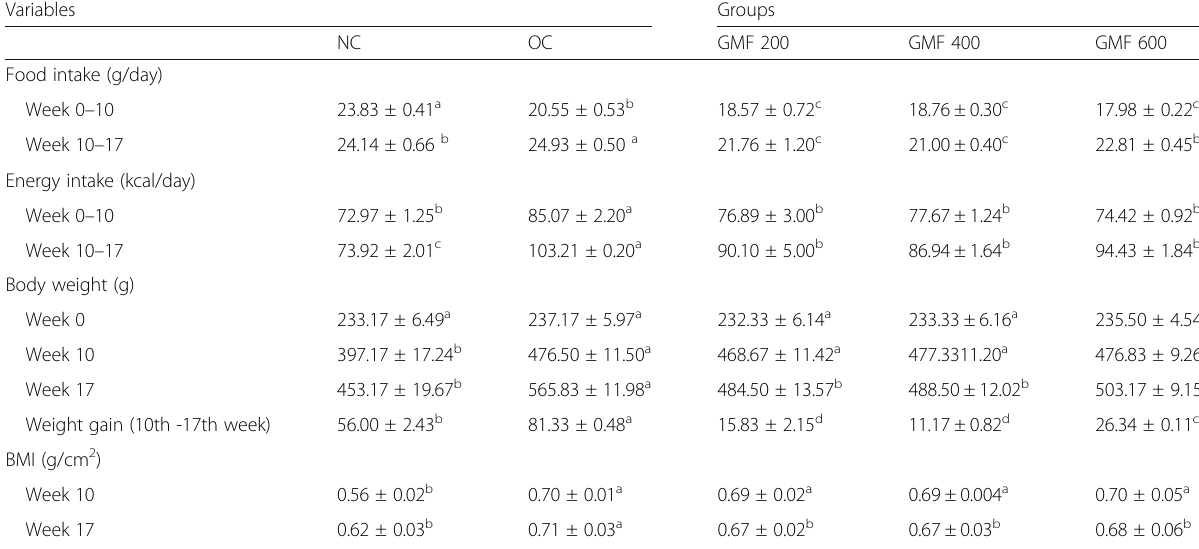
Table 1 The effect of GMF supplementation on dietary intake, body weight and BMI